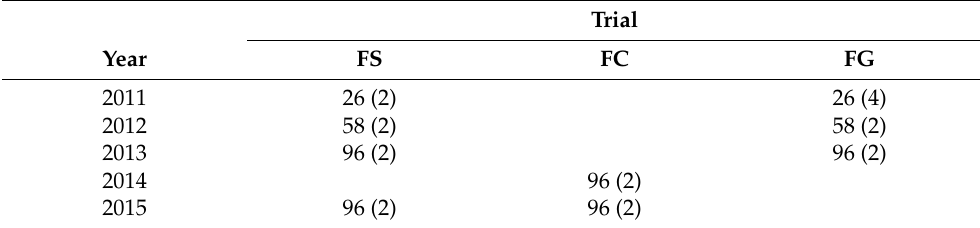
Table 1. Replicates (in brackets) and number of lines tested from the complete set of 96 lines within each trial inoculated with F. sporotrichioides (FS), F. culmorum (FC), or F. graminearum (FG) between 2011 and 2015. The smaller subset of lines tested in 2011 was extended by adding another set of 32 lines in 2012, which was finally extended by further 38 lines in